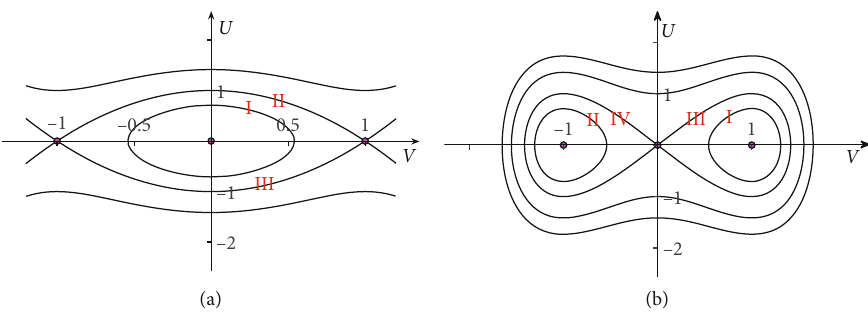
= 1 and (b) a = − 1 4 4